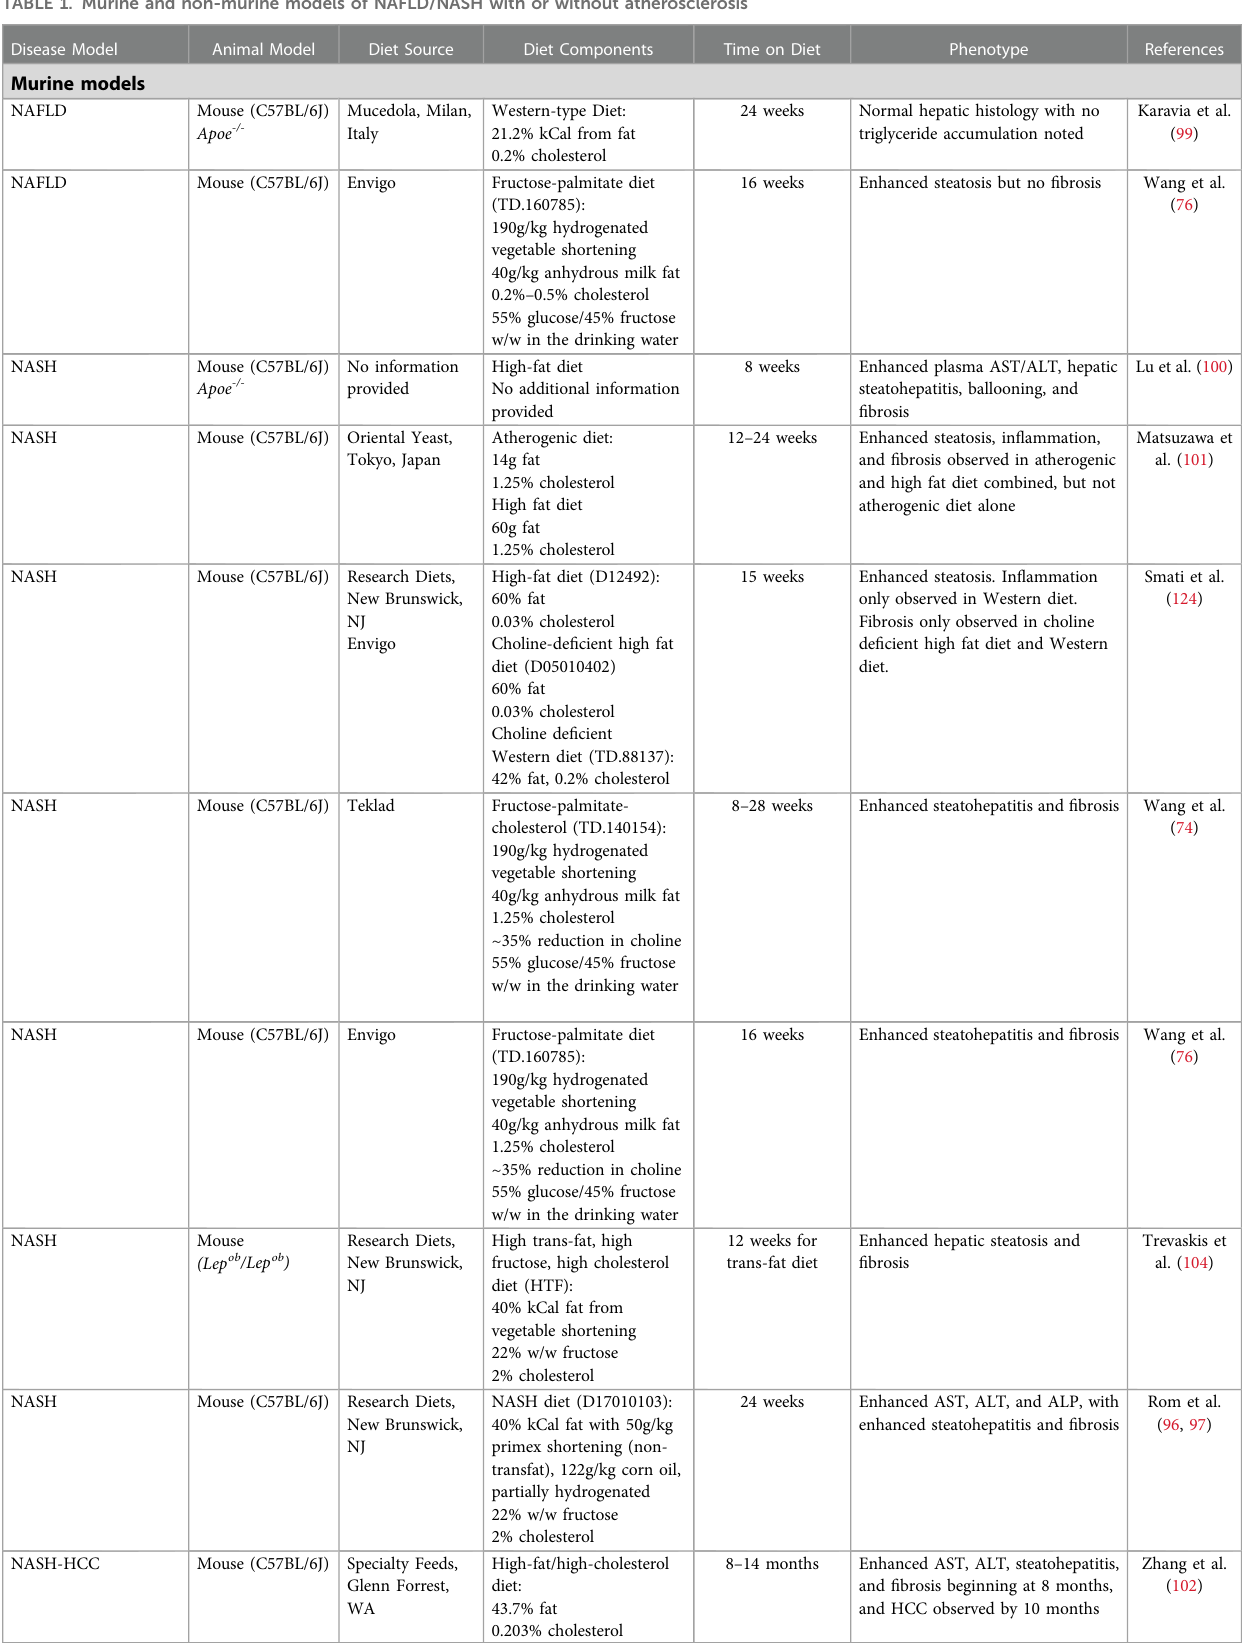
TABLE 1. Murine and non-murine models of NAFLD/NASH with or without atherosclerosis Disease